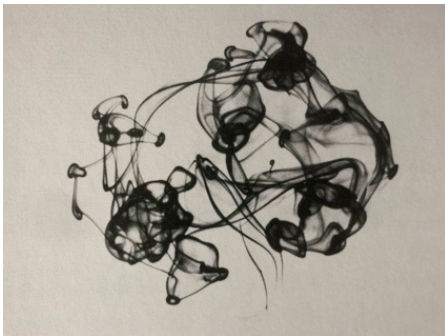
Figure 17. Herbert Matter, Ink and Glycerine , 1943. Silver Gelatin Print, 9 × 12 1/16”. Private Collection. Their 1943 experiments with the flow of energy within matter provided Pollock in at in Shimmering Substance , he embraced the technique of pouring. With his underlying sense of structure, Pollock was able to start a canvas somewhat automatically. In his